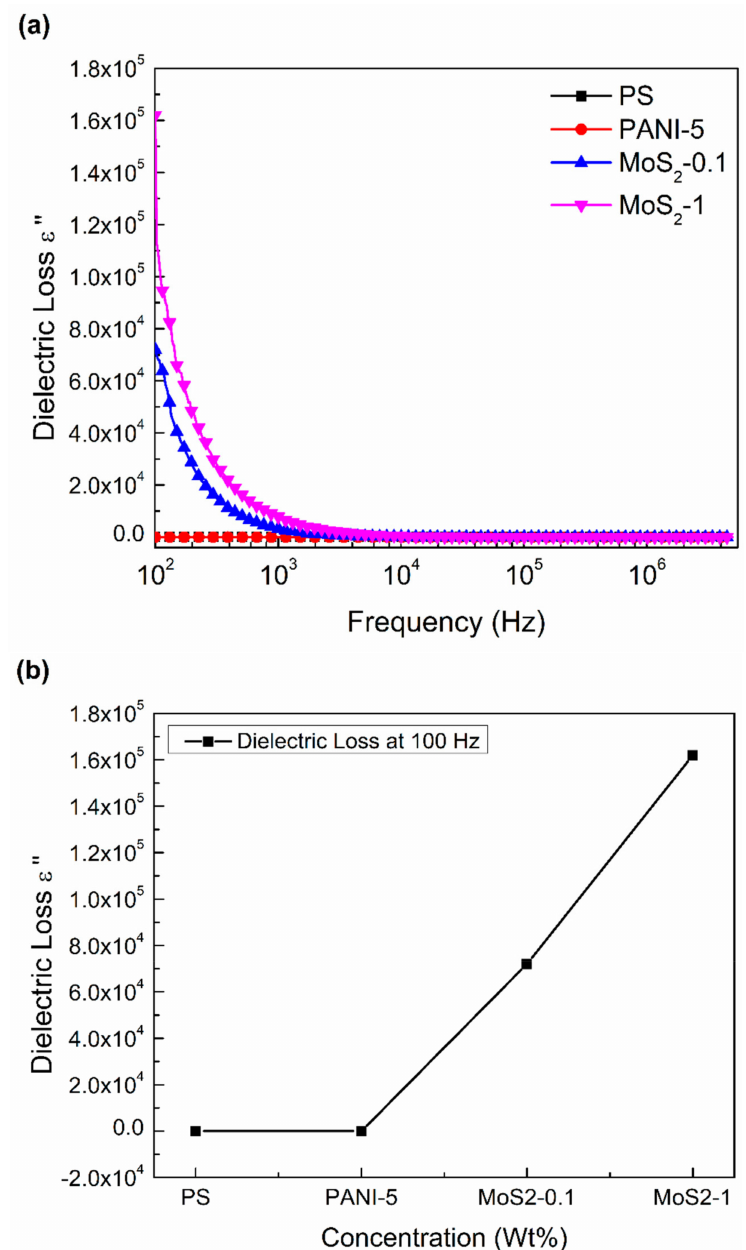
Figure 5. Dielectric loss versus frequency of ( a ) PS, PANI, PS / PANI-5 wt % polymer blend, and PS / PANI / MoS 2 hybrid polymer composites. Dielectric loss for ( b ) PS, PANI, PS / PANI-5 wt% polymer blend, and PS / PANI / MoS 2 hybrid polymer composites at 100